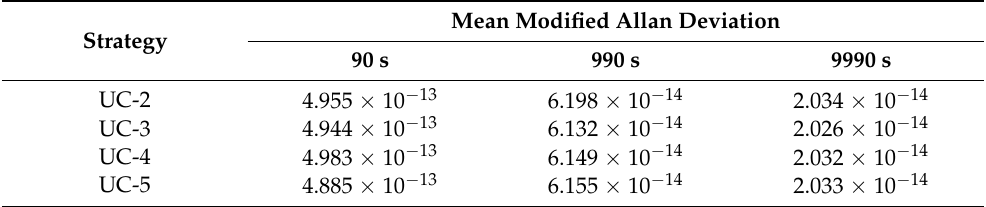
Table 7. Mean MDEV values over 16 time links (except for BRUX-MRC1) generated with Galileo dual-, triple-, four-, and five-frequency UC PPP at an average time of 90, 990, and 9990 s.